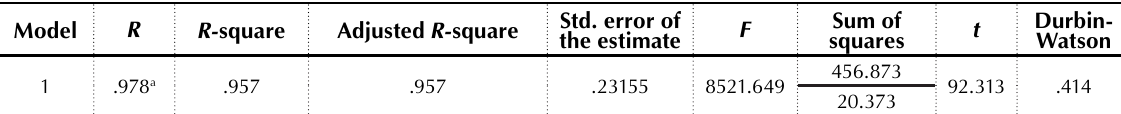
Table 4. Model summary